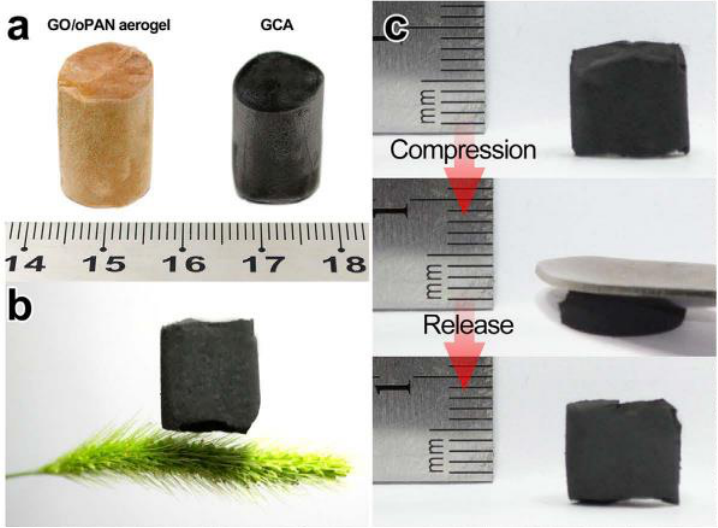
Figure 27. Photographs demonstrating ( a ) shape maintenance, ( b ) low density, and ( c ) and shape recovery capability of GCA (reproduced from the work in [63] with permission).